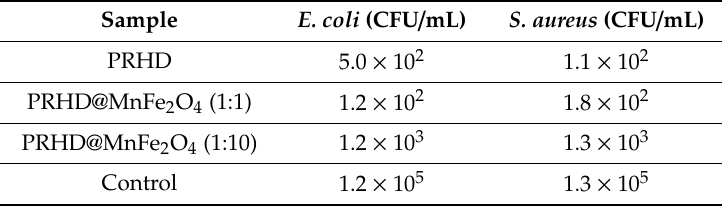
Table 3. Antibacterial assessment of di ff erent PRHD@MnFe 2 O 4 binary